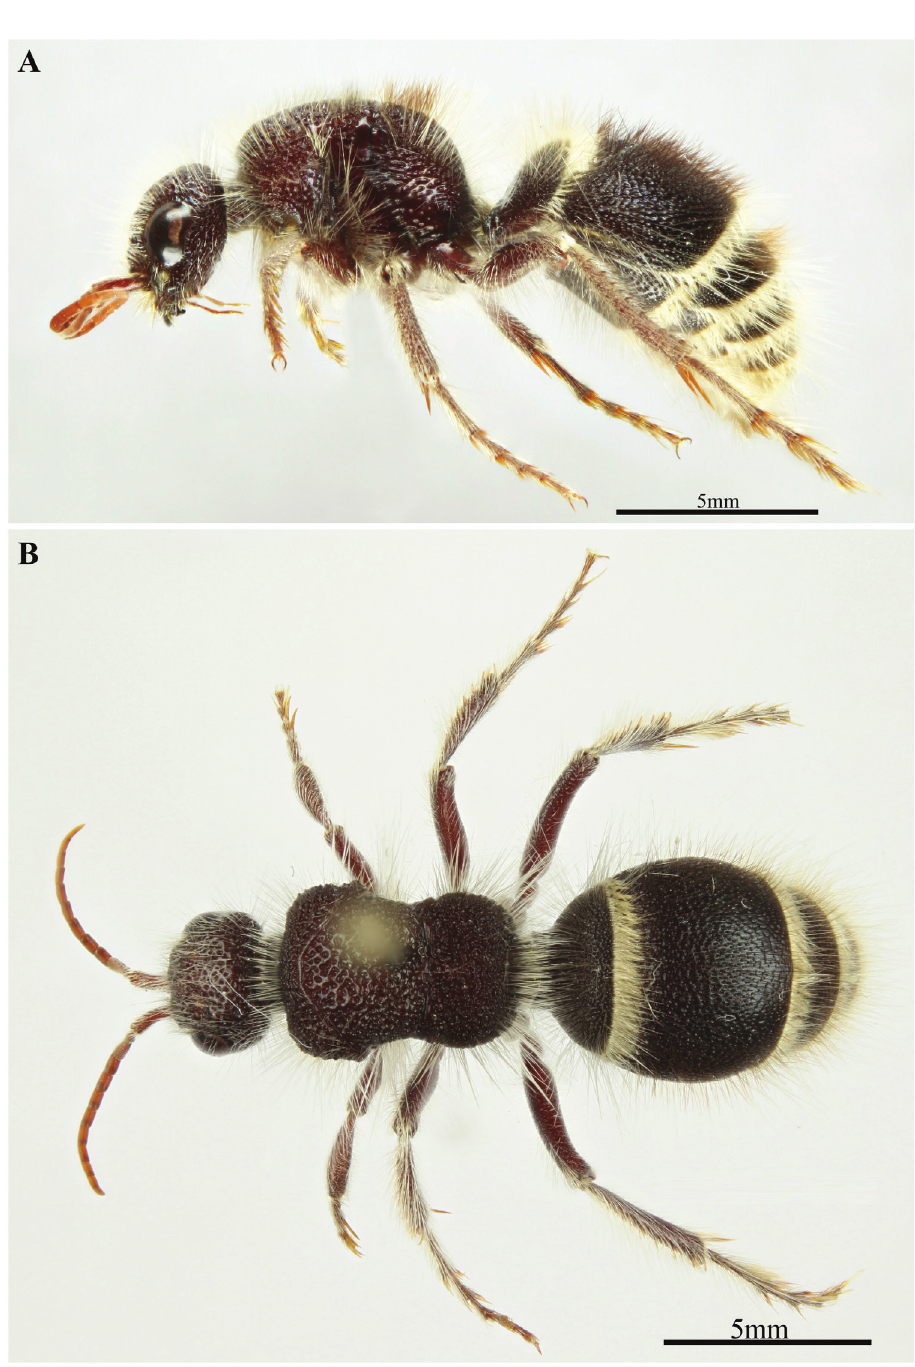
Figure 26. Pseudophotopsis maura Bischoff (Female) A, B habitus, lateral and dorsal views,